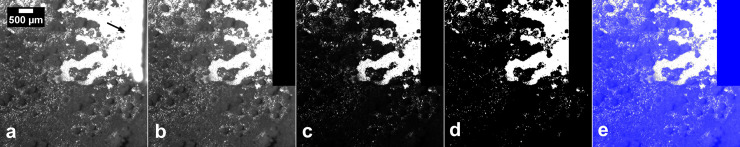
Example of a high speed image still, showing the image analysis steps performed to calculate the area cleaned (white).The image is taken from a video where the standoff distance between the ultrasonic scaler tip and the biofilm was 2 mm. The ultrasonic scaler used was operated at 29 kHz, with a tip vibration amplitude of 57 μm at the free end. The biofilm in this image was grown on rough (sand blasted and acid etched) titanium discs, Ra = 2 μm: (a) raw high speed image still showing the biofilm on the rough titanium surface, the black arrow shows the position of the scaler tip (b) image after the ultrasonic scaler tip was removed, (c) Image after gamma filter applied, (d) segmented image using automatic thresholding, and (e) overlay of the segmented image in blue on the raw image demonstrating that the segmentation is accurate.